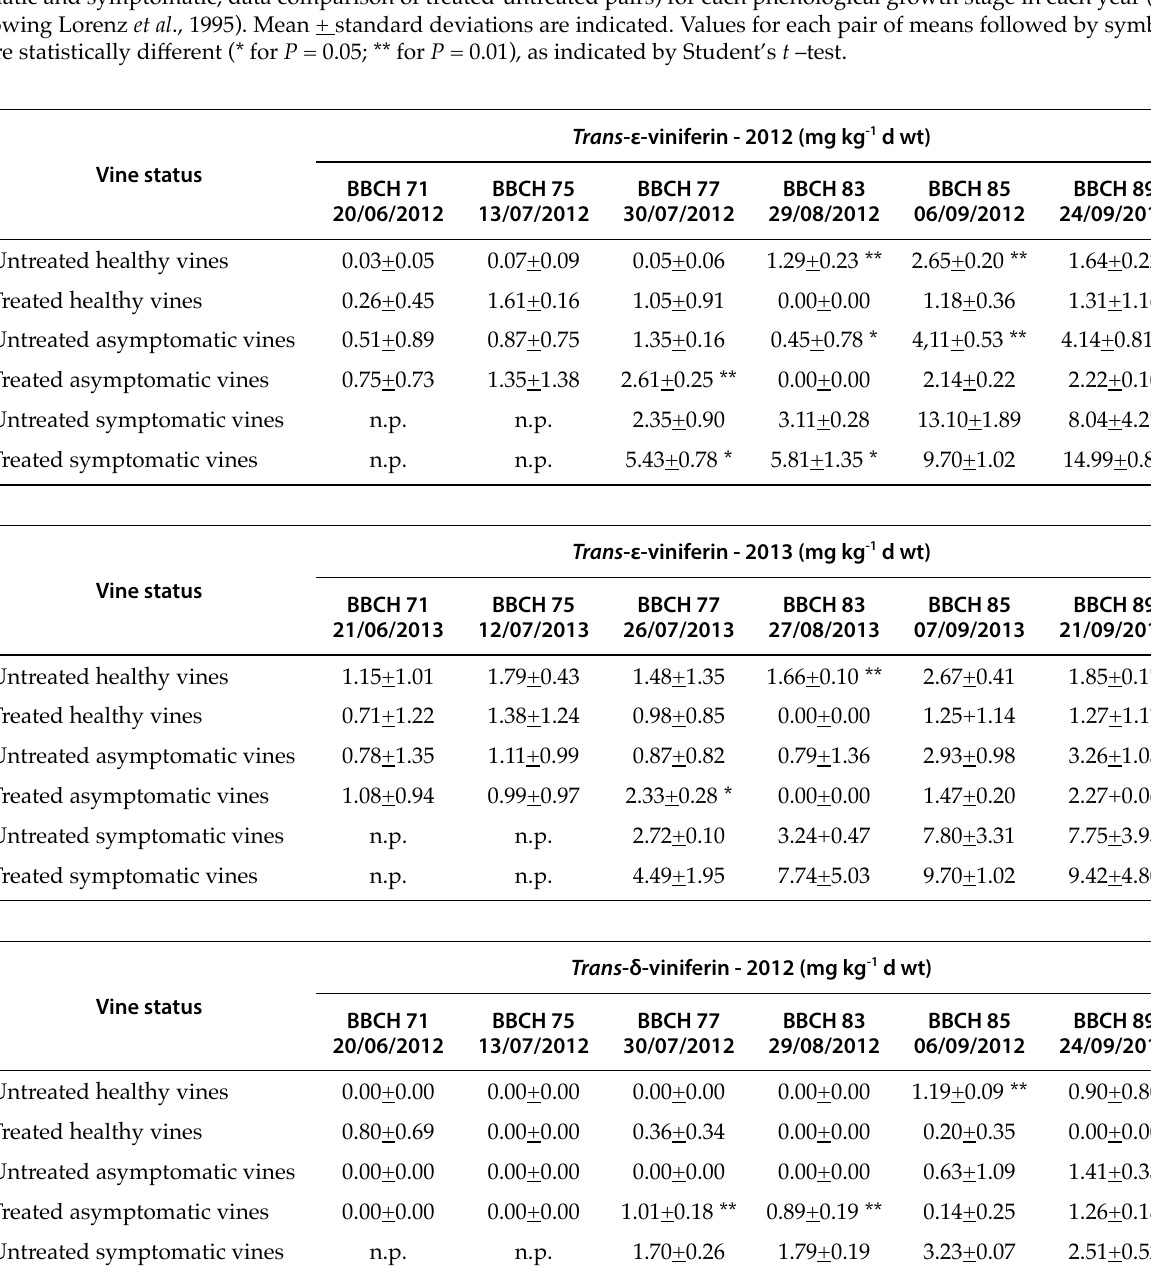
Table 1. Mean amounts of trans -ε-viniferin (a, b), trans -δ-viniferin (c, d) and trans -pterostilbene (e, f) in leaves of healthy grapevines, and of asymptomatic and symptomatic vines affected by GLSD, treated or untreated with foliar nutrient mix - ture in 2012 and 2013. Each value is the mean of six replications of the leaf data individually obtained from six vines for each grapevine status. The statistical analysis separately compared leaf data from each grapevine status (healthy, asympto- matic and symptomatic; data comparison of treated-untreated pairs) for each phenological growth stage in each year (fol- lowing Lorenz et al ., 1995). Mean + standard deviations are indicated. Values for each pair of means followed by symbols are statistically different (* for P = 0.05; ** for P = 0.01), as indicated by Student’s t